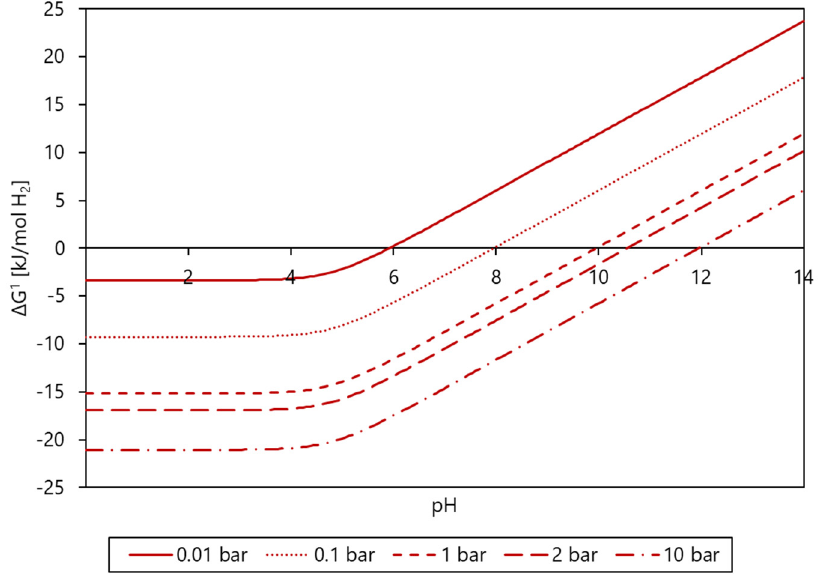
Figure 2. Actual Gibbs energy changes for butanol formation from butyrate and hydrogen (Equation (2)) as a function of pH at different H 2 partial pressures of 0.01 bar (___), 0.1 bar (…..), 1 bar (----), 2 bar ( _ _ _ ), and 10 bar (_ . _ . _) at 50 mM of butyrate and 10 mM of butanol.